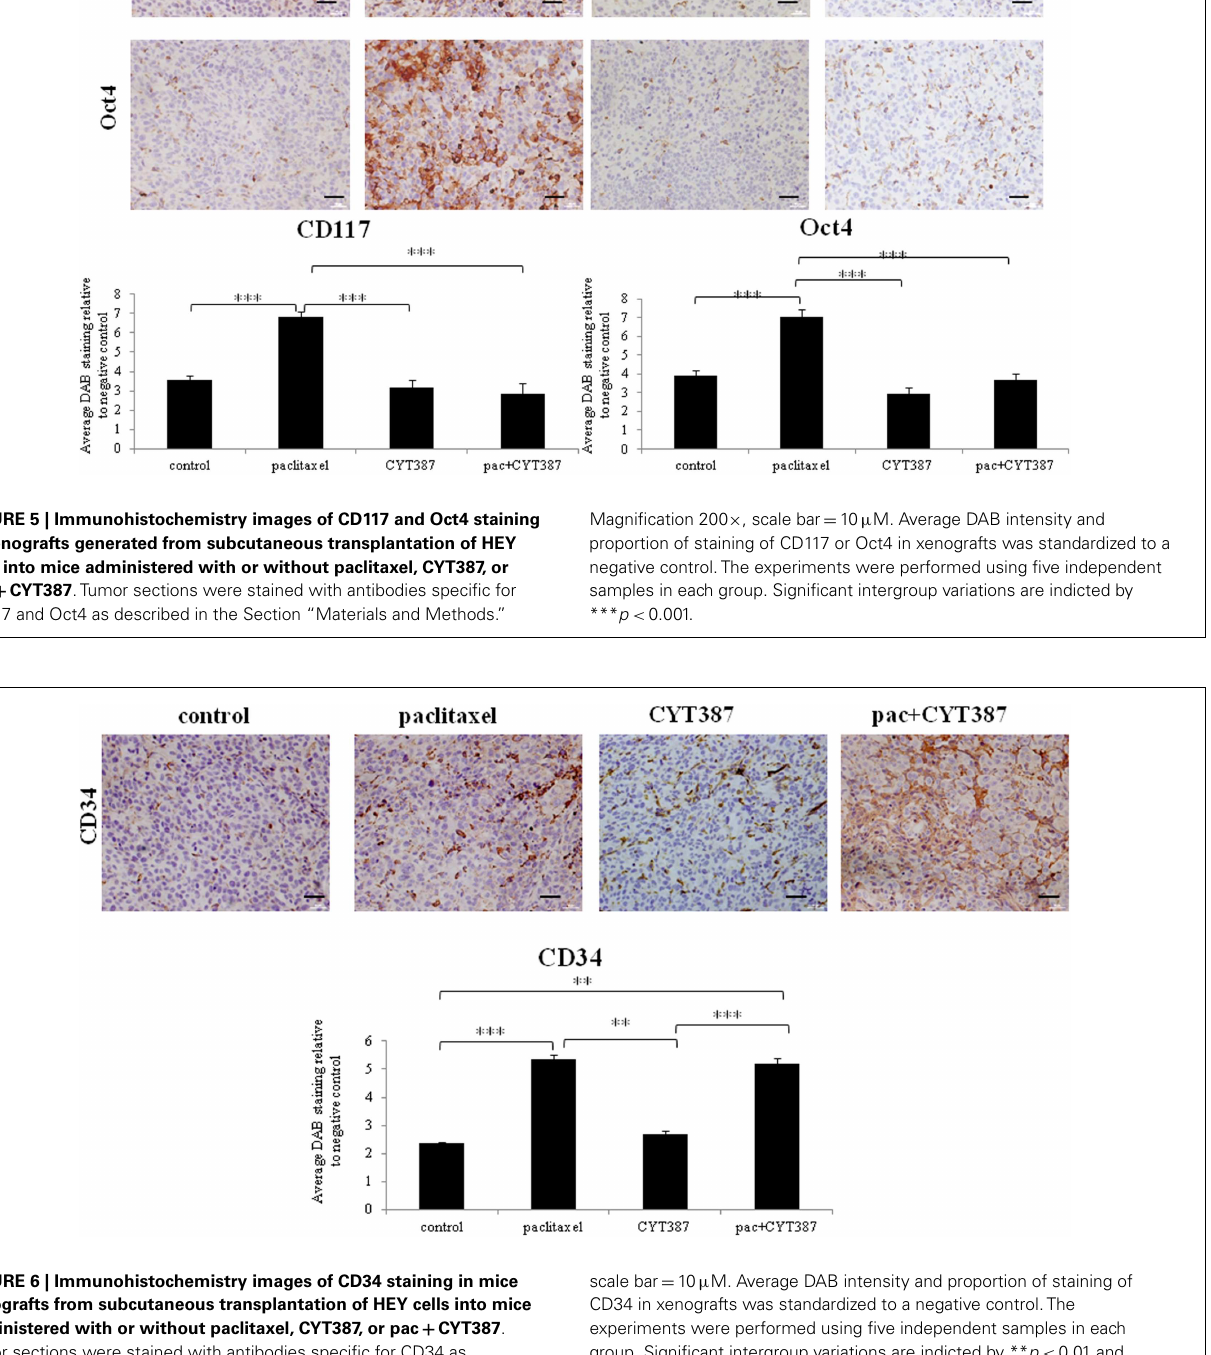
FIGURE 6 | Immunohistochemistry images of CD34 staining in mice xenografts from subcutaneous transplantation of HEY cells into mice administered with or without paclitaxel, CYT387, or pac + CYT387 . Tumor sections were stained with antibodies specific for CD34 as described in the Section “Materials and Methods.” Magnification 200 × ,